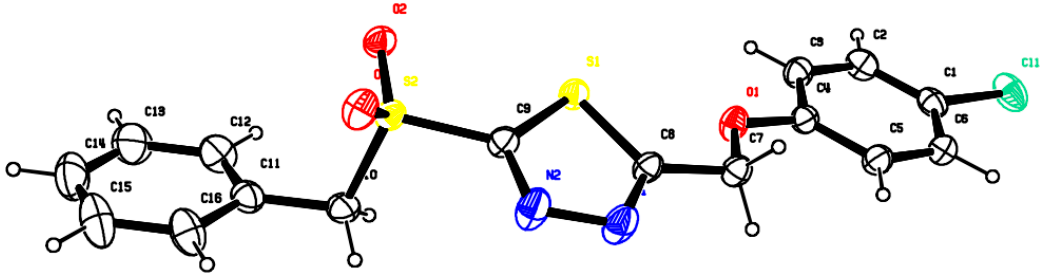
Figure 5. Crystal structure of compound 5II-9 .